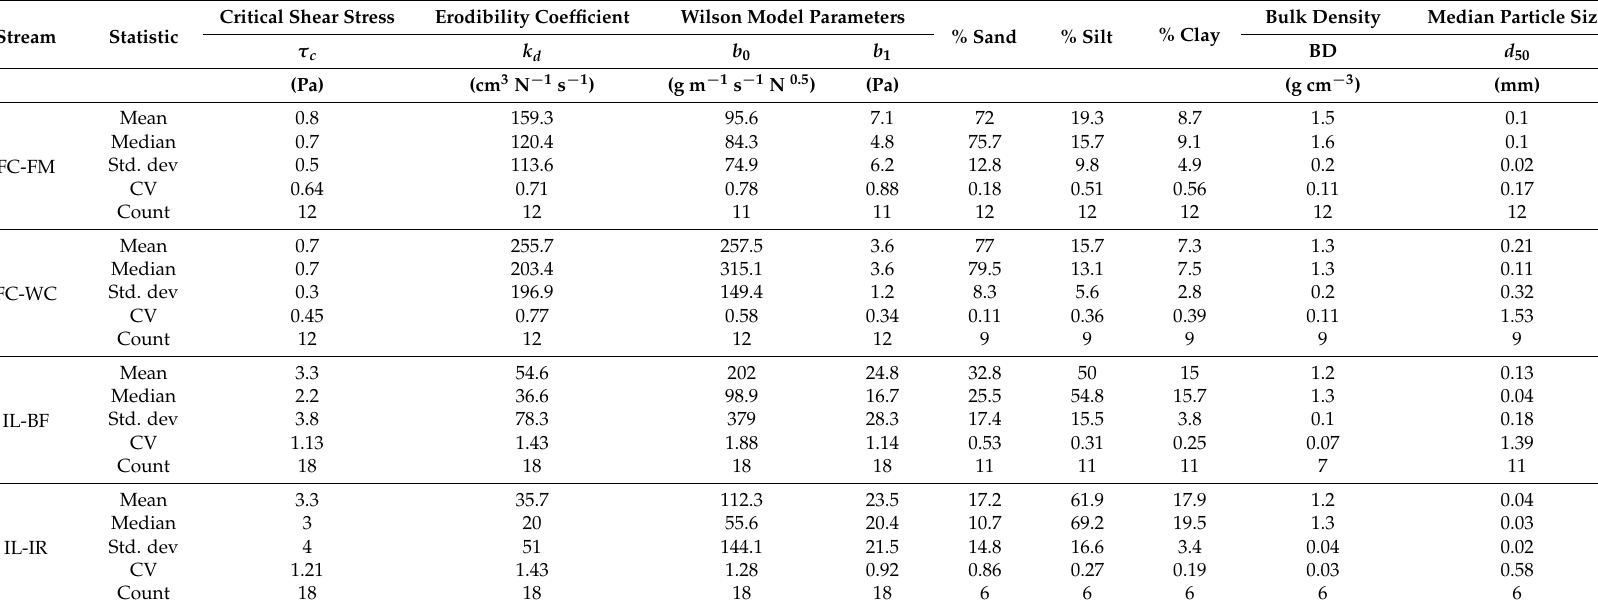
Table 2. Summary statistics for soil parameters measured along Fivemile Creek (FC-FM), Willow Creek (FC-WC), Barren Fork Creek (IL-BF), and Illinois River (IL-IR).